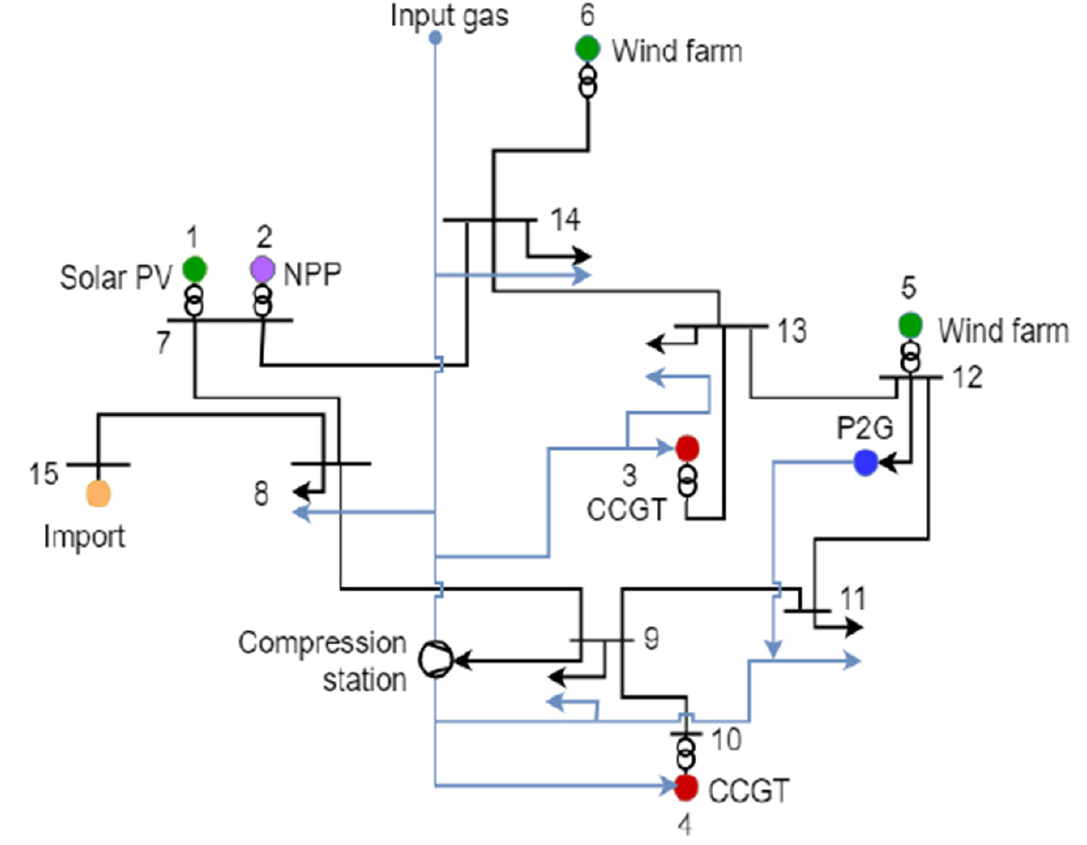
Figure 1. Scheme of the considered IES. Table 3. The considered NPPs configurations.